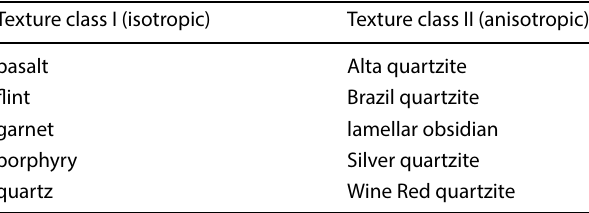
Table 7 Texture classes of the rock samples Texture class I (isotropic)